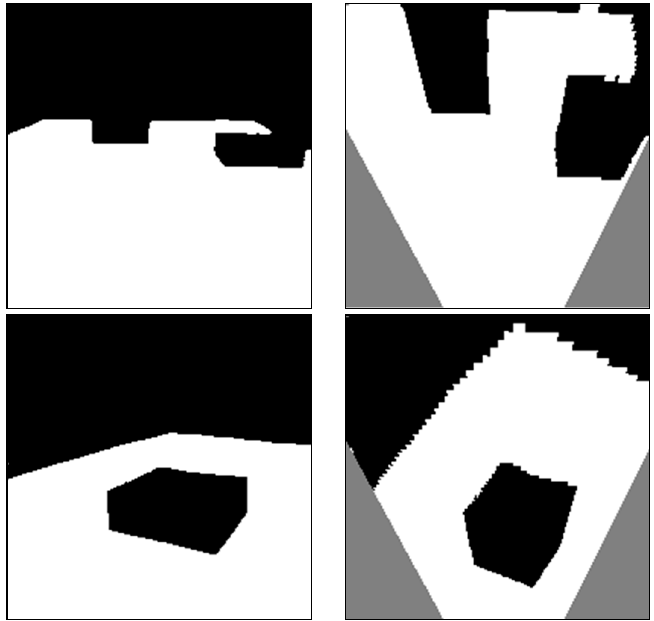
Figure 15. Perspective correction in semantic segmentation image with four different obstacle positions.